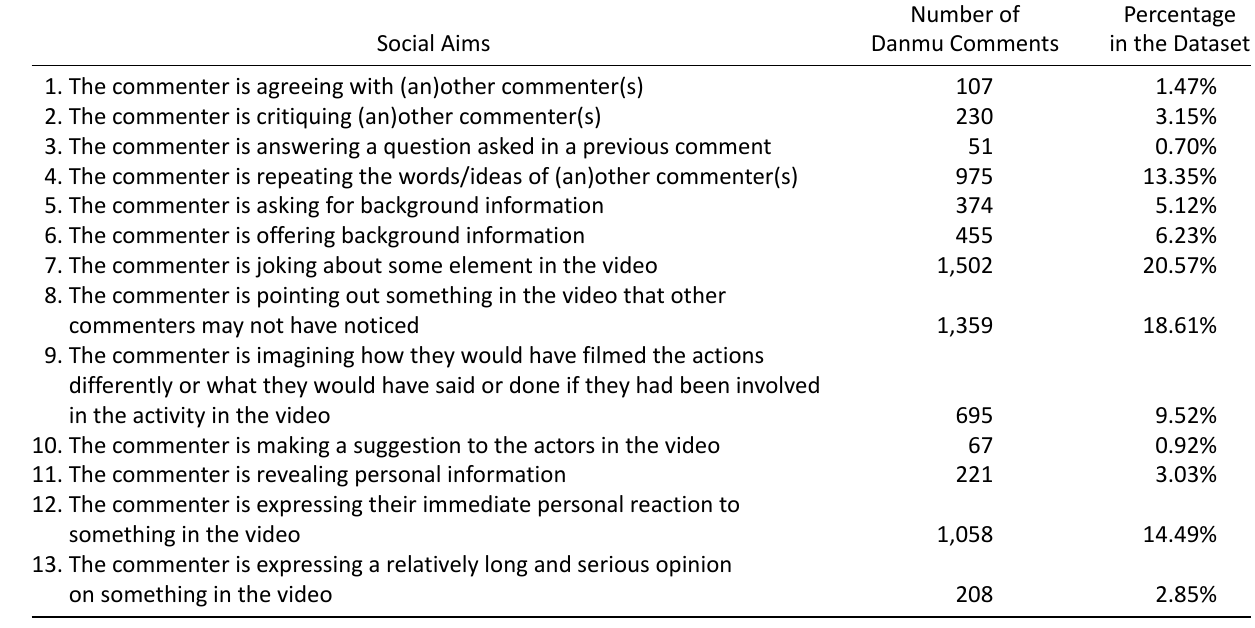
Table 2. Distribution of social aims of danmu